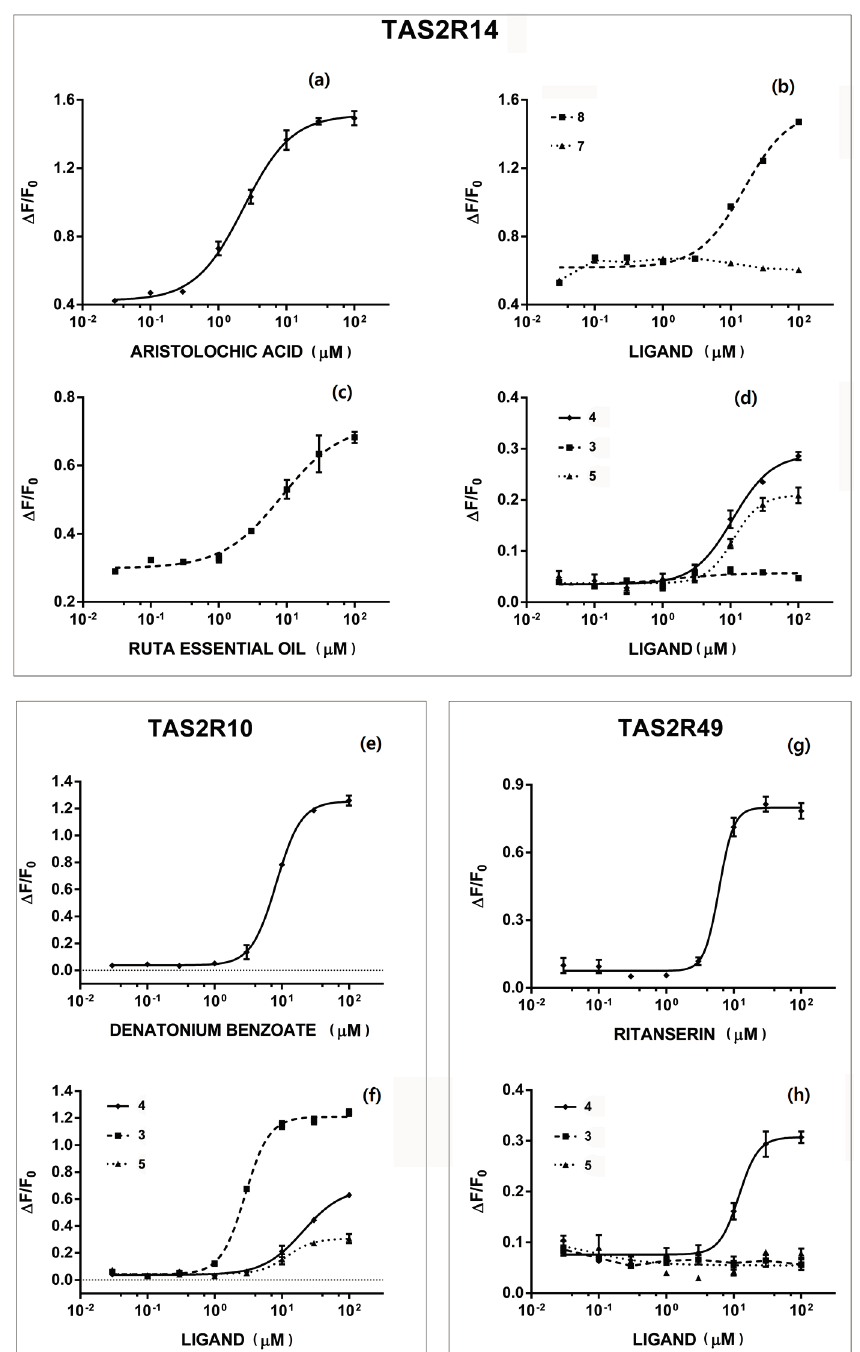
Figure 2. In vitro assays on TAS2R receptors of rue phytochemicals and essential oil. Each dose/response curve was performed at least three times using replicates ( n = 4). TAS2R14: ( a ) aristolochic acid; ( b ) Compounds 7 and 8 ; ( c ) ruta essential oil; ( d ) Compounds 3 , 4 and 5 . TAS2R10: ( e ) denatonium benzoate; ( f ) Compounds 3 , 4 and 5 . TAS2R49: ( g ) ritanserin; ( h ) Compounds 3 , 4 and 5